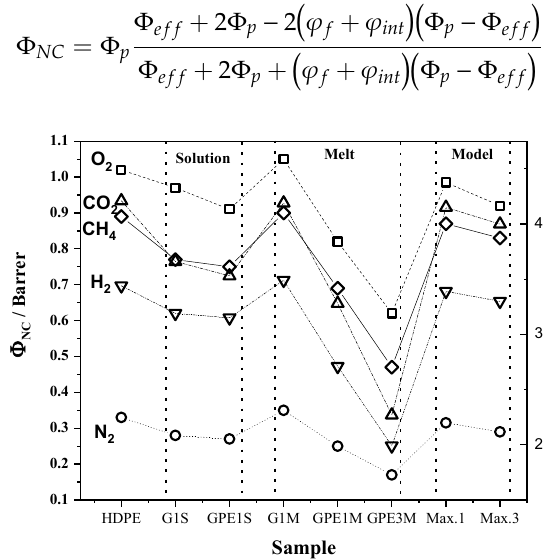
Figure 9. Comparison of the experimental permeability for all samples tested with the theoretical prediction using the Maxwell model.